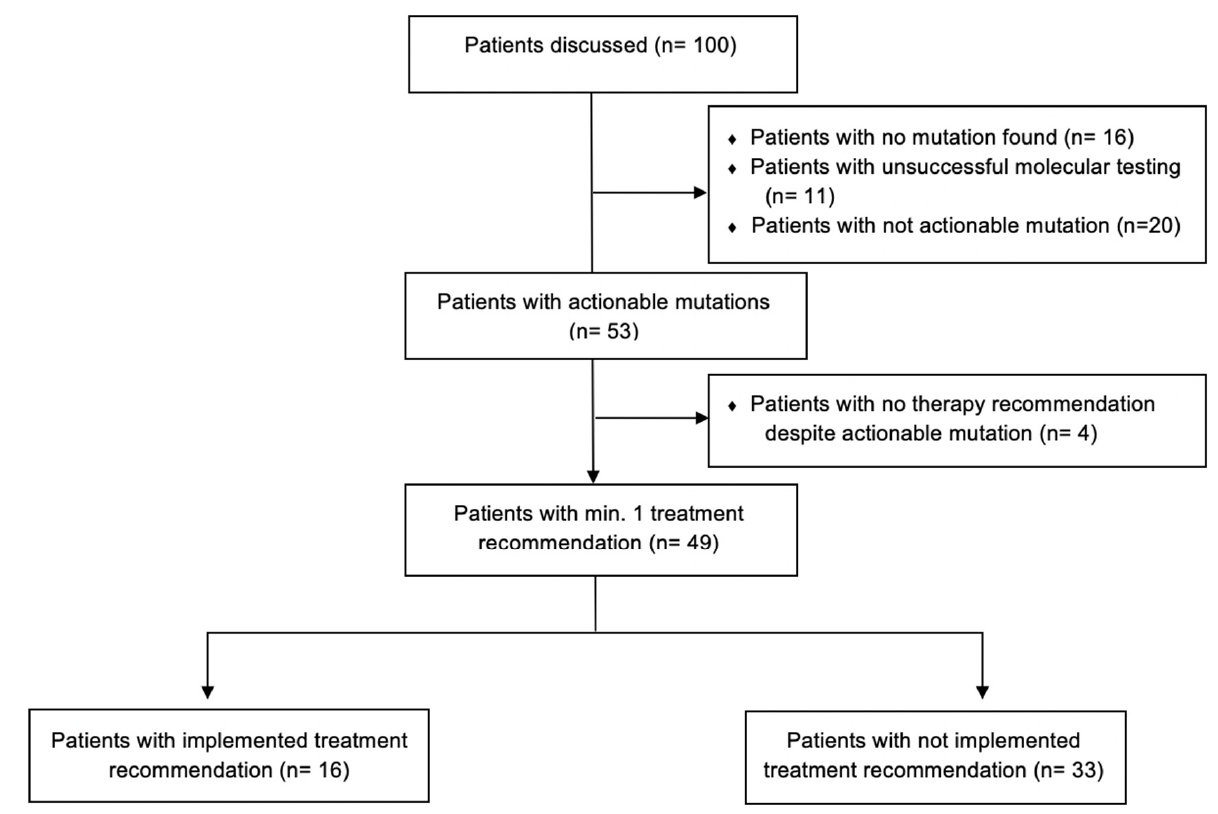
Figure 5. Consort flow diagram showing the results of Molecular Tumor Board (MTB) case discussions based on molecular diagnostics results and implementation of treatment recommendations in our cohort (n = 100).